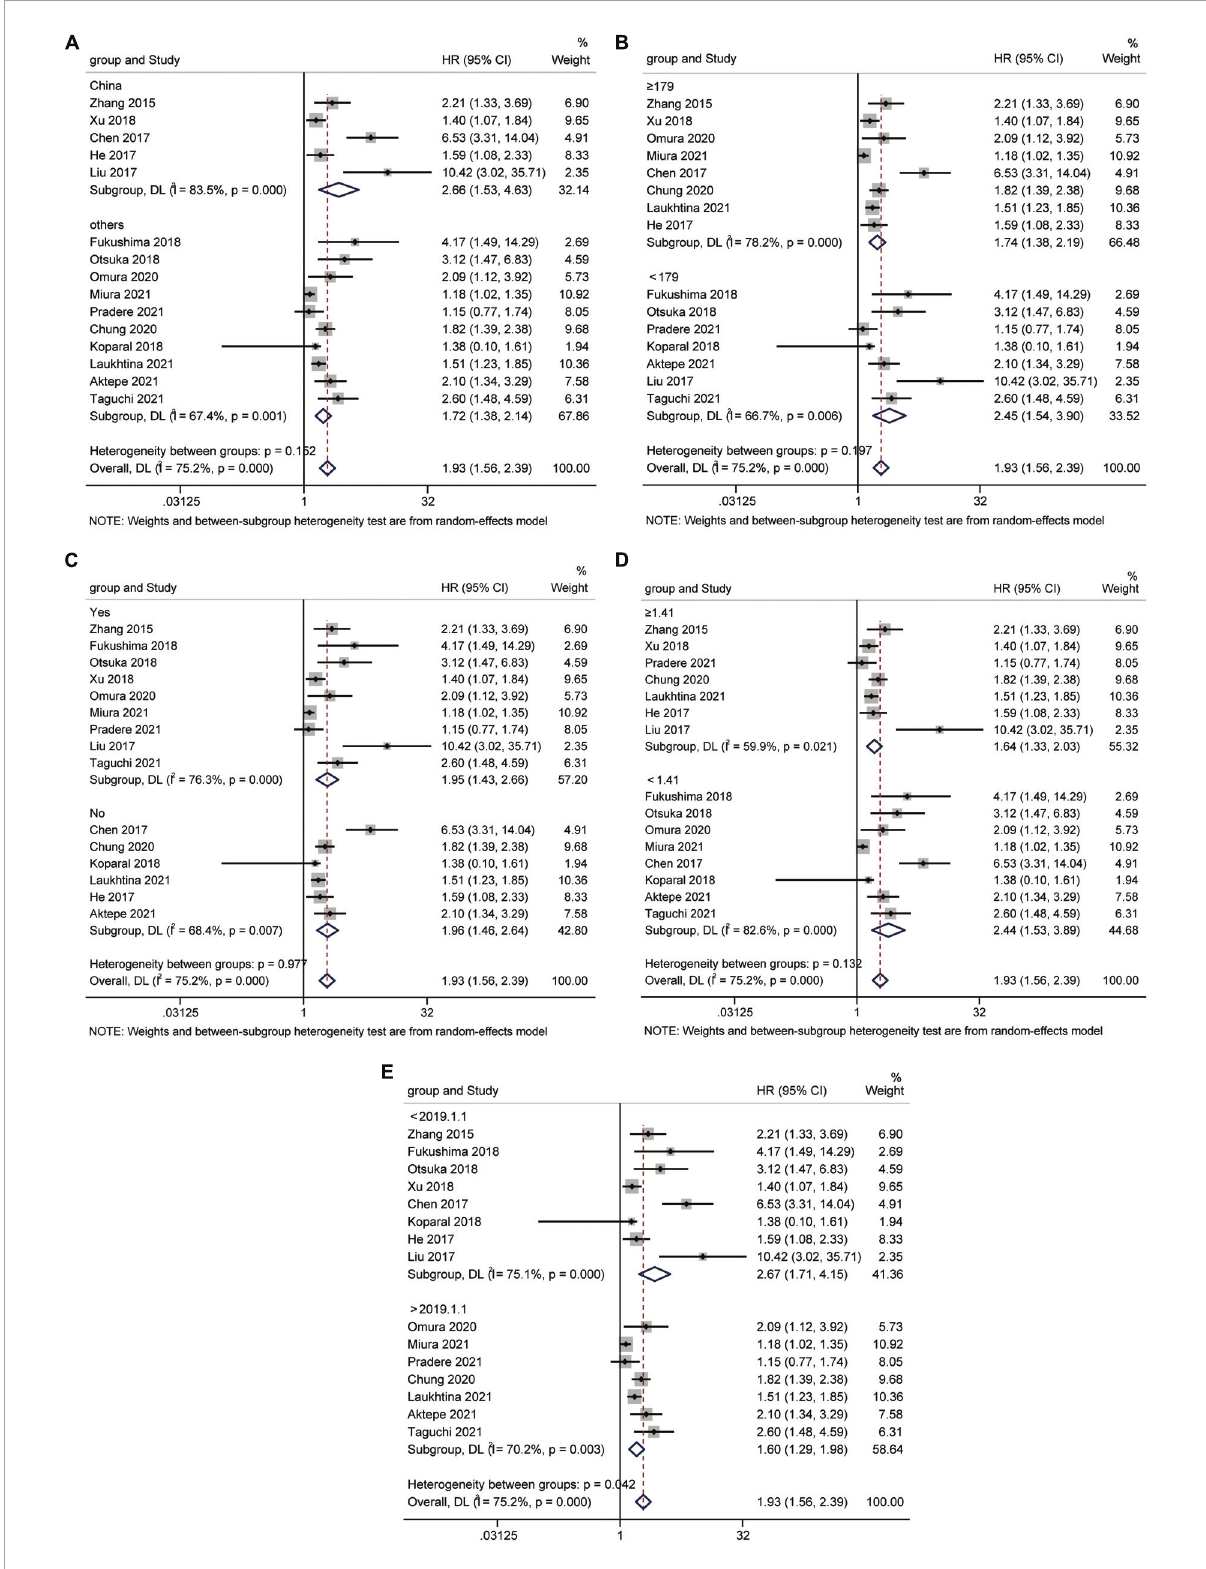
FIGURE3 Forest plot for subgroup analysis of OS and AGR. (A) Subgroup analysis of OS and AGR according to ethnicity; (B) Subgroup analysis of OS and AGR according to sample size; (C) Subgroup analysis of OS and AGR according to urothelial carcinoma (yes or no); (D) Subgroup analysis of OS and AGR according to cut-off values; (E) Subgroup analysis of OS and AGR according to publication